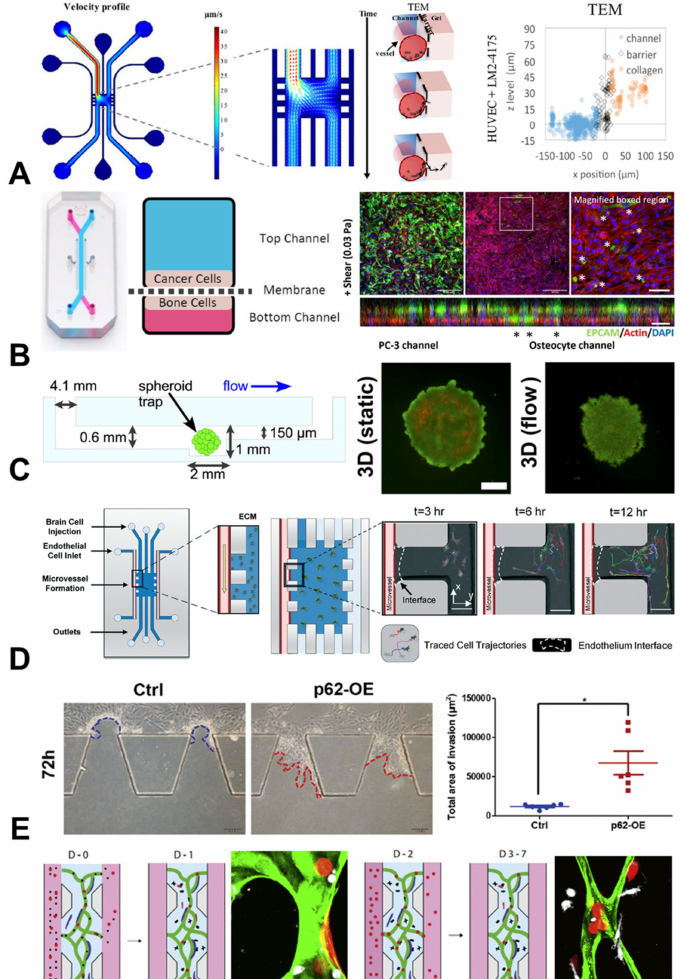
Figure 3. Organ-chip models investigating the metastatic cascade. ( A ) A chip model investigating the effect of fluid flow and barrier formation on the transendothelial migration (TEM) of breast cancer cells [36]. ( B ) A mechanobiological model showing increased invasion of breast and prostate cancer cells when co-cultured in a chip with mechanically-stimulated osteocytes (scale bar = 20 µ m; * indicates instance of invasion) [38]. ( C ) Live/dead staining of breast cancer spheroids, showing more growth under flow conditions when compared to static conditions (scale bar = 200 µ m) [39]. ( D ) Live- cell tracking of migration trajectories of glioblastoma cells over 12 h in a chip with microvessels, crossing an epithelial barrier and entering the extracellular matrix (ECM) (scale bar = 100 µ m) [41]. ( E ) Increased invasion of breast cancer cells in a chip when over-expressing the p62 gene (p62-OE) (scale bar = 100 µ m; * indicates p < 0.05, two-tailed Student’s t -test) [42]. ( F ) The rate of breast cancer cell (red) extravasation from microvessels (green) over seven days (D-0 to D-7) was affected by the presence of monocytes (white) (scale bar = 10 µ m) [43]. Figures reproduced with